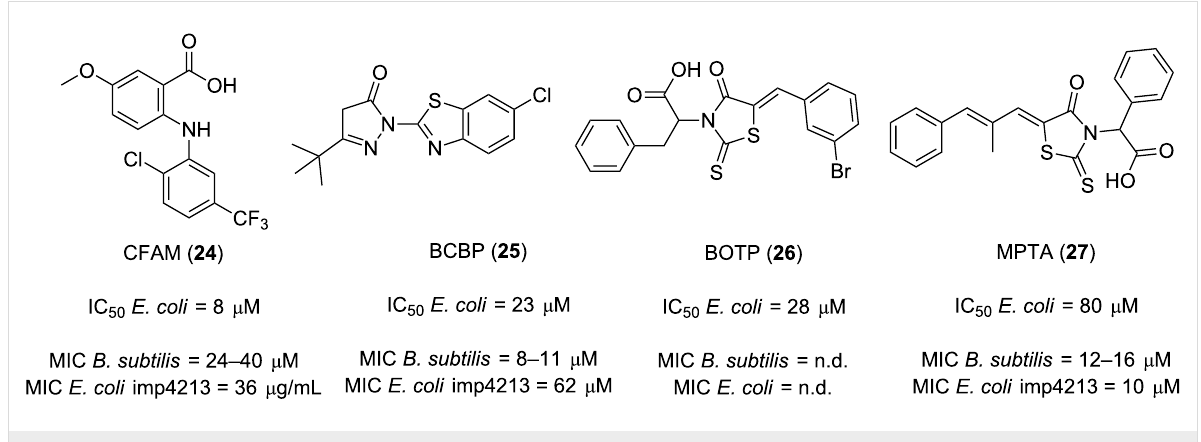
Figure 6: SSB protein–protein interaction inhibitors identified by HTS.